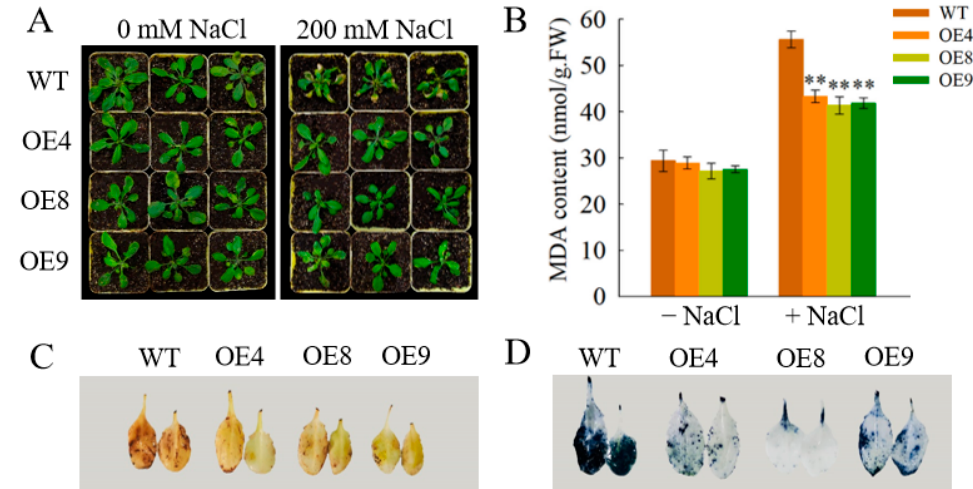
Figure 7. Effect of salt treatment on OfSPL11 − overexpressed lines and WT Arabidopsis . ( A ) Effect of different concentrations of NaCl treatment on Arabidopsis plants in soil; ( B ) malondialdehyde (MDA) content of Arabidopsis plants; ( C ) detection of H 2 O 2 levels in Arabidopsis ; and ( D ) detection of O 2 − levels in Arabidopsis . Each experiment had three biological replicates. ** p < 0.01 were used to determine statistical